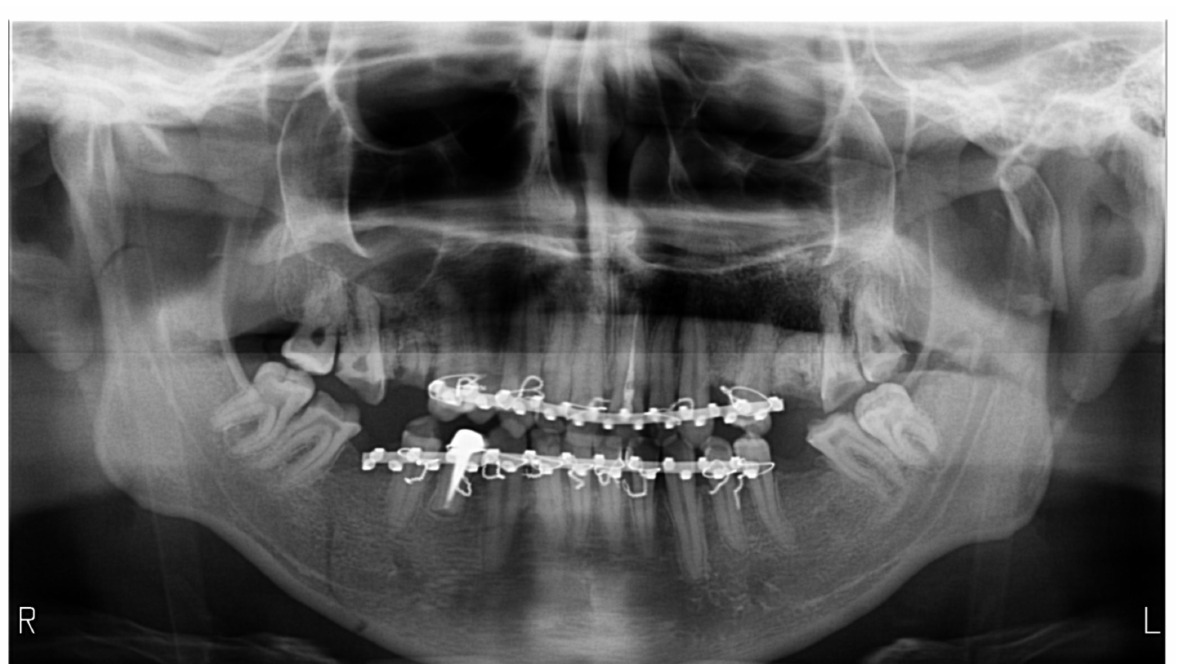
Figure 1. Panoramic radiography exemplifies the air present in the palatoglossal space as a radiolu- cent band. The patient presents a triple fracture of the mandible, bilateral low subcondylar and the body on the right side, with bimaxillary